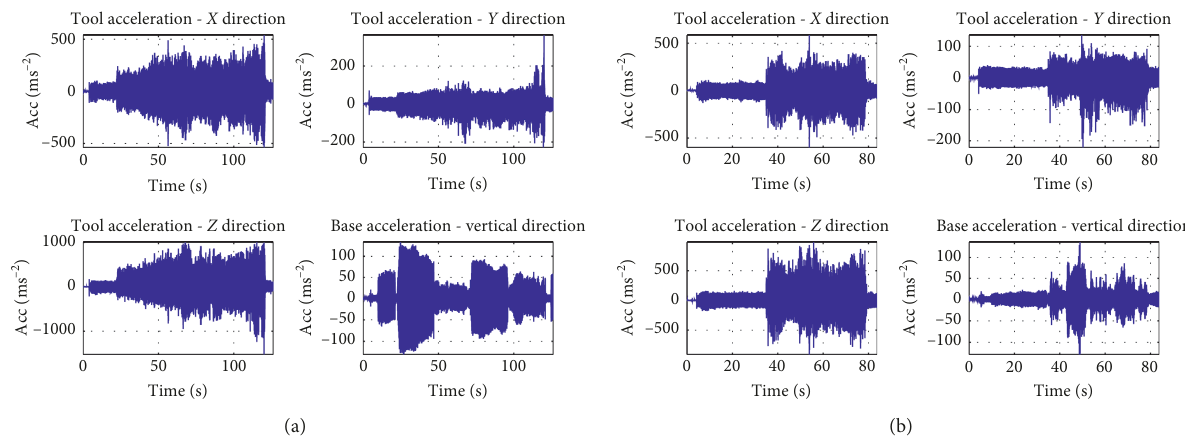
Figure 2: Timed evolutions of acquired acceleration for the case of squared shape (a) and circular shape